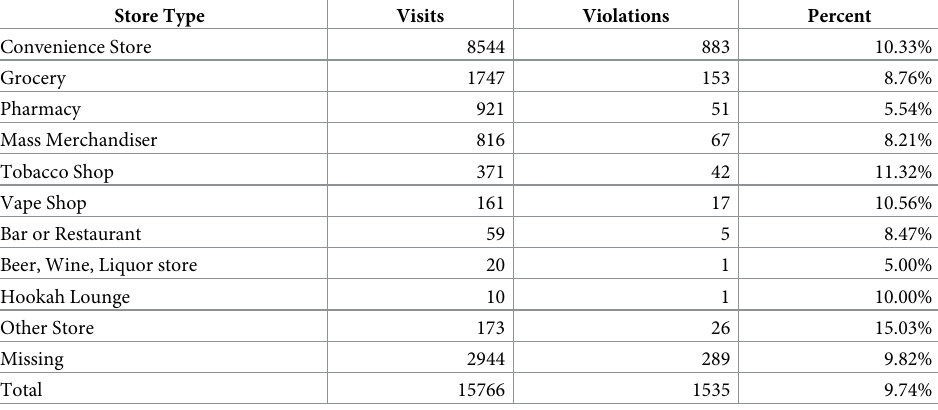
Table 2. Counts of compliance check visits, sales to minor violations, and percent of visits with a sales violation by store type in 2012–2021. Store